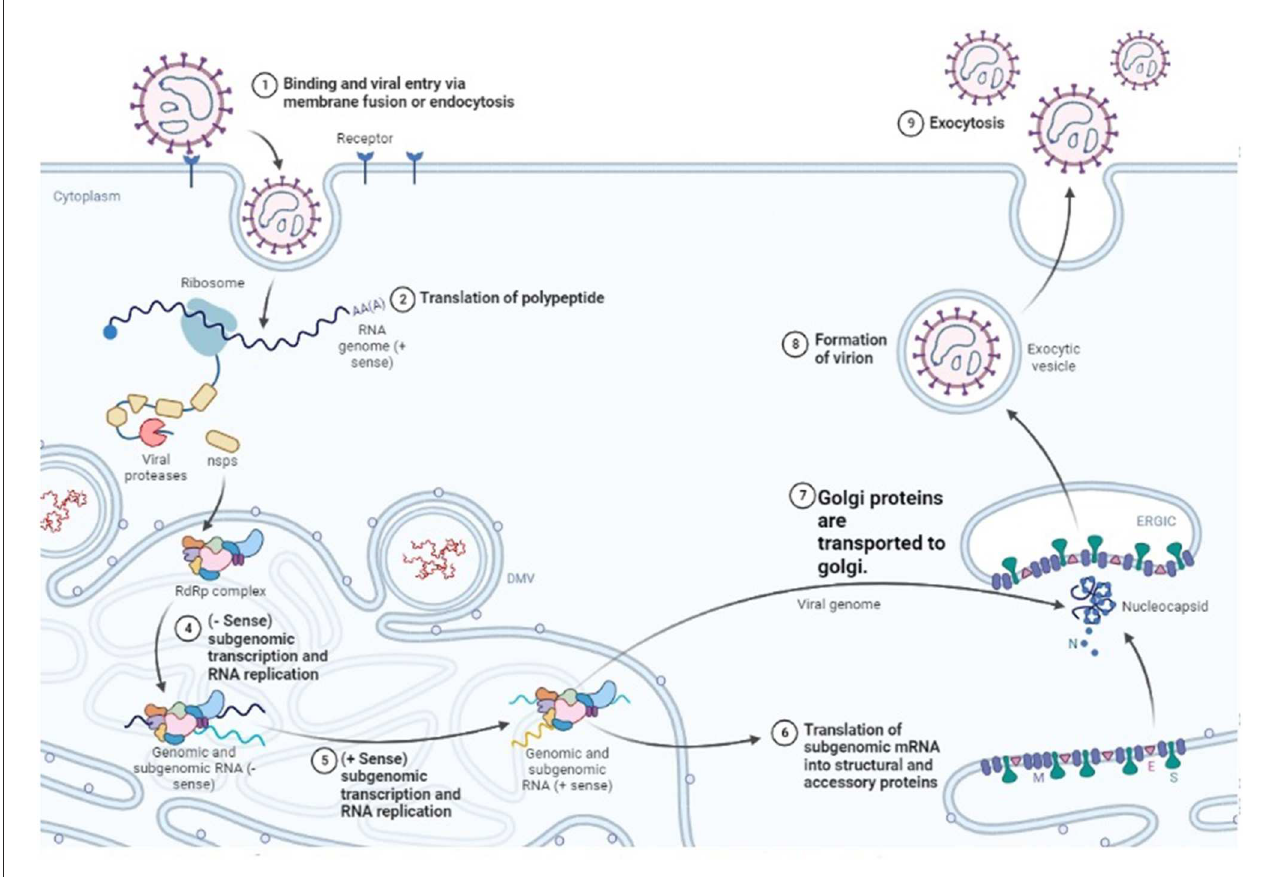
FIGURE4 Replication cycle of Nairo virus within a host cell (Drawn by BioRender